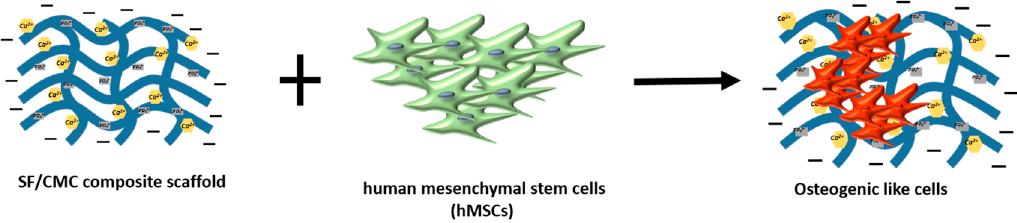
Figure 10. The SF/CMC composite scaffold was able to fix Ca 2+ via chelation and to favor the homogeneous deposition and nucleation of the calcium/phosphate (Ca/PO 4 ) crystals on the grafting matrix. Moreover, when loaded by hMSCs, the scaffold allowed hMCs differentiation towards osteoblastic cells. Redrawn from ref [81].